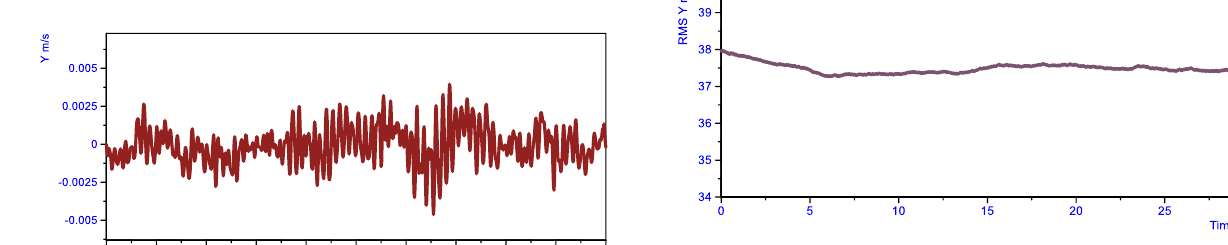
Fig. 6. The diagram of the effective RMS velocity of vibrations along the X axis; n = 3600 rpm, M =75 Nm, α wtr = 5°